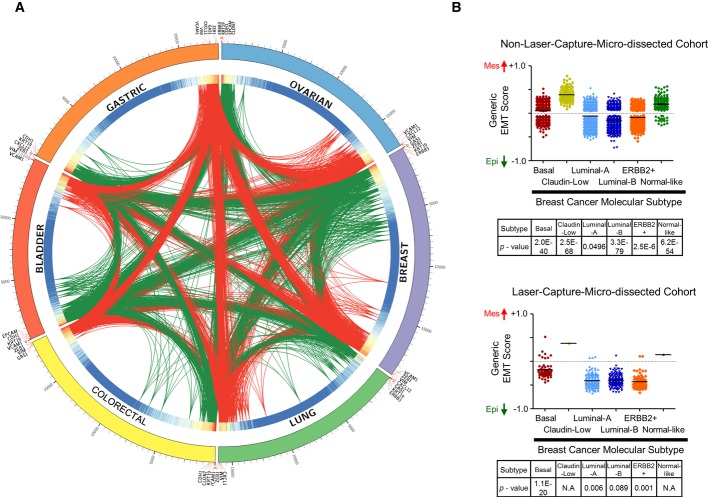
Derivation and application of generic epithelial-mesenchymal transition (EMT) signatureCircos plot illustrating the generic EMT signature: the overlap of ovarian (blue), breast (purple), lung (green), colorectal (yellow), bladder (red) and gastric (orange) cancer-specific EMT signatures is shown. Links indicate overlapping genes (red = mesenchymal, green = epithelial). Heatmap on the inner ring indicates weight computed based on Significance Analysis of Microarray (SAM) fold-change, false discovery rate, Receiver Operating Characteristics (ROC) and number of samples of a gene in each cancer-specific EMT signature (red = high, blue = low weight). On the outermost ring, genes are represented by ticks and aligned from the highest SAM fold-change to the lowest for each cancer type. Selected genes are labelled.EMT score (mean ± SEM;y-axis) of breast cancer molecular subtypes as predicted using ssGSEA and signature from Pratet al (2010) in non-laser-capture micro-dissected (non-LCM) cohort (n = 3,992; upper panel) and LCM cohort (n = 417; lower panel). The Mann–WhitneyU-testP-value of binary comparison for each subtype is given. Colour code: maroon, Basal; yellow, Claudin-low; light blue, Luminal-A; dark blue, Luminal-B; orange, ERBB2+; green, Normal-like. N.A, not applicable. Note that noP-value is available for Claudin-low and Normal-like subtypes in lower panel becausen < 3.